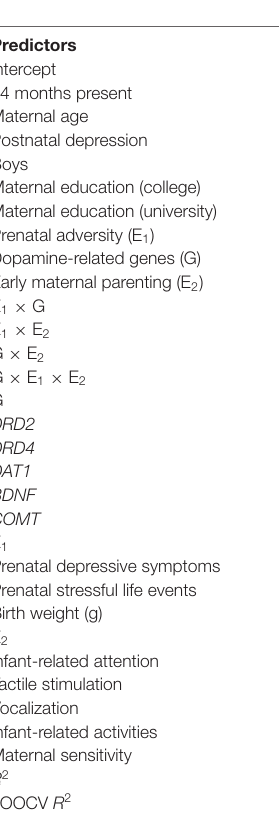
TABLE 3 | Predicting toddler attentional competence at 18 and 24 months based on the three-way interaction of prenatal adversity, dopamine-related genes, and early maternal parenting behaviors with/without imputation. Without